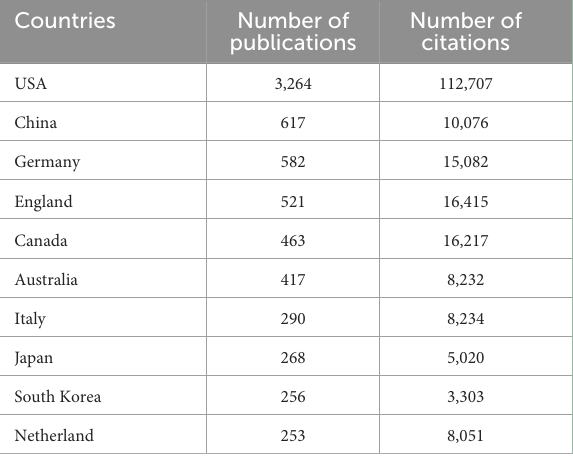
FIGURE1 A flowchart of the study procedure.